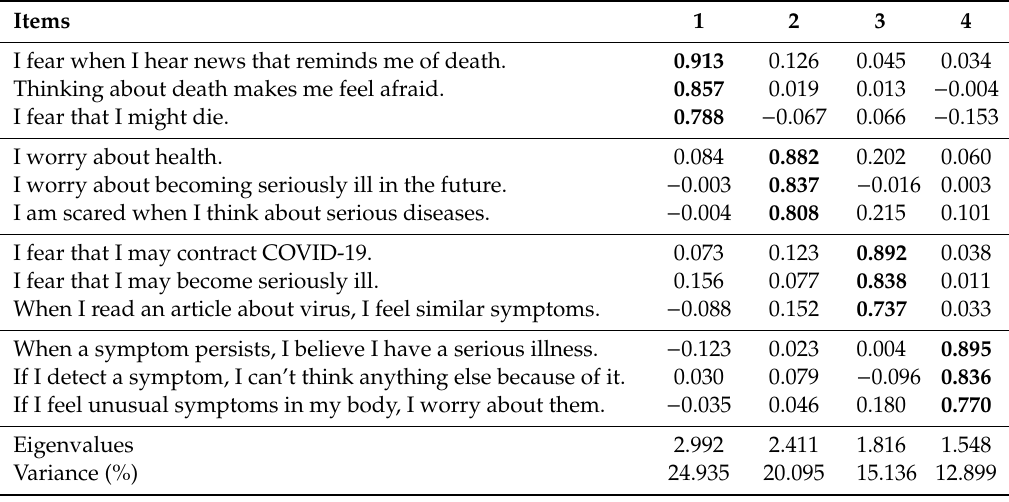
Table 2. Results of exploratory factor analysis and scale